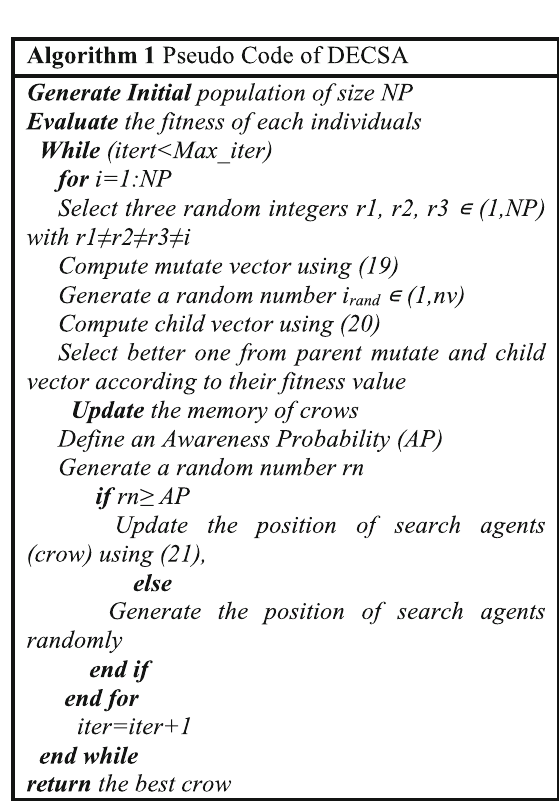
Fig. 1 String representation of population vector